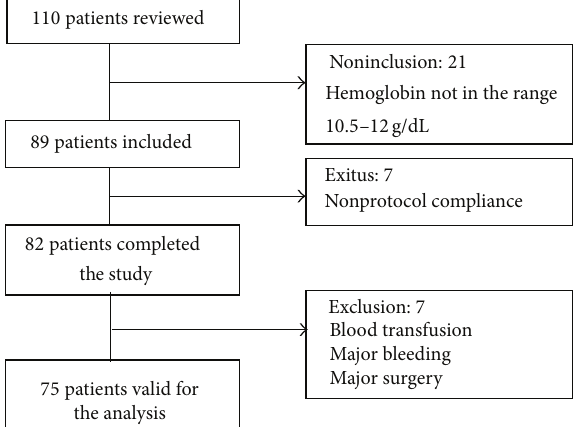
Figure 1: Patients included in the